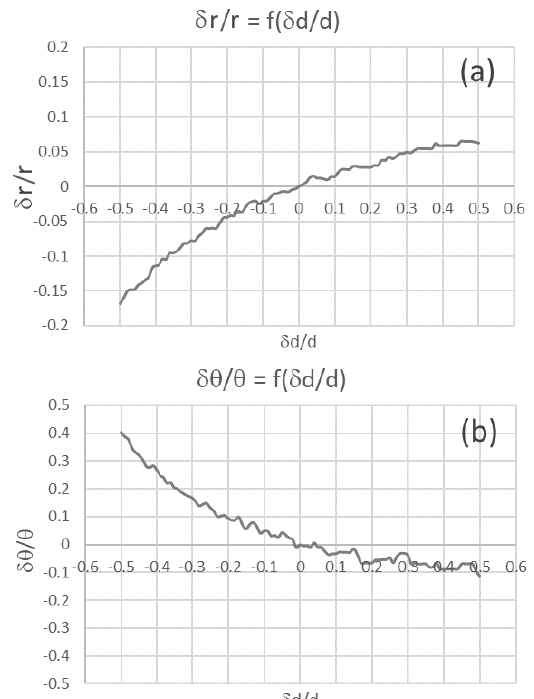
Fig. 10. Sensitivity of (a) r and (b)  parameters as a function of concrete density